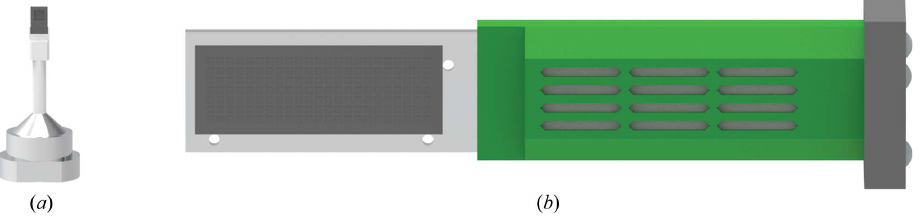
Figure 1 Chip designs for the on-chip crystallization of proteins. ( a ) Roadrunner I chips have overall dimensions of 4.5 (cid:3) 2.5 mm and up to 10 000 micro-pores, and are equipped with a standard magnetic base, making them compatible with data collection on most MX synchrotron beamlines. ( b ) Roadrunner II chips are much larger, with overall dimensions of 32 (cid:3) 12 mm, and provide up to 300 000 micro-pores for crystals. They are glued onto an aluminium support frame (shown in light gray), which is mounted on a standard magnetic mount (shown in black). Room-temperature data collection with Roadrunner II chips requires a special scanning stage with a long travel range of more than 32 mm, such as the Roadrunner II goniometer (Tolstikova et al. , 2019). The so-called ‘humidor’ (shown in green) can be slid over the chip to protect the crystals from drying out and from light